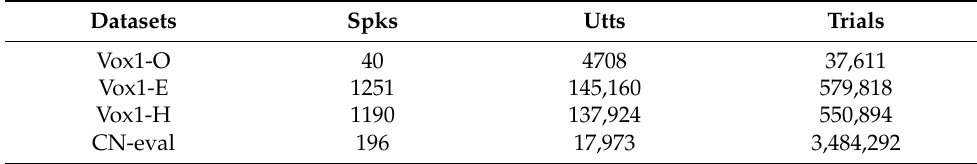
Table 1. The detail of test